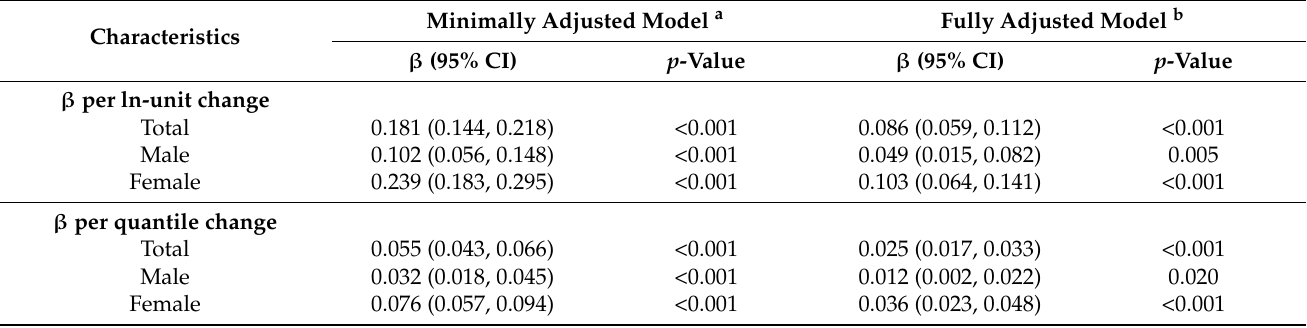
Table 2. Associations of blood Mn levels and male VAT mass in the US general